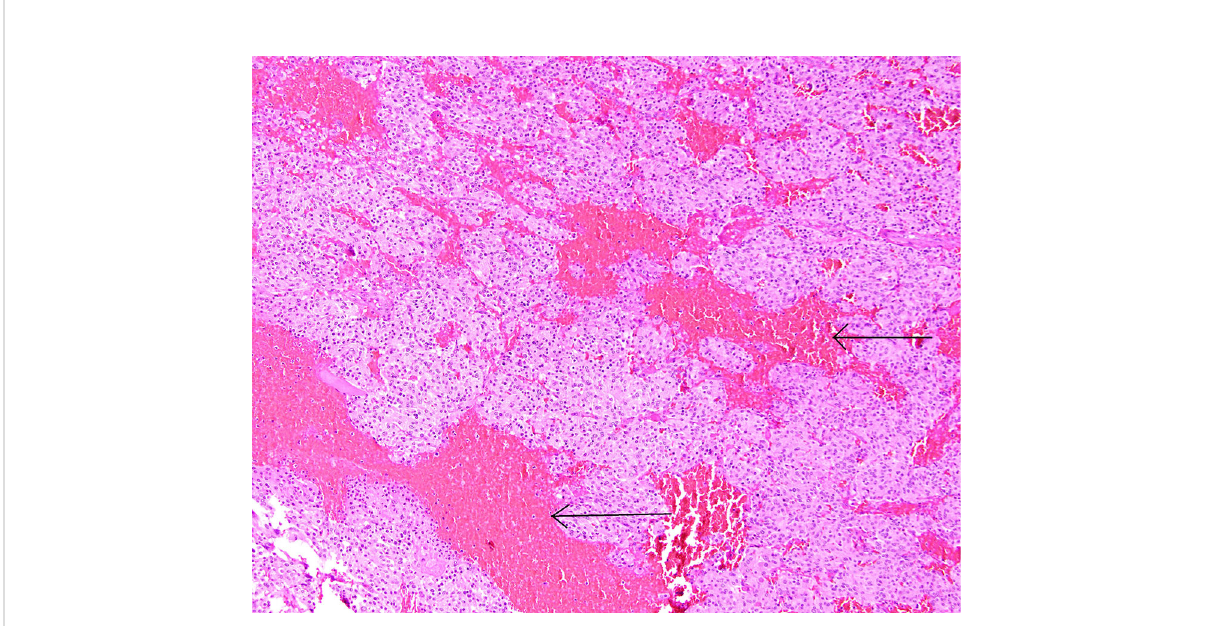
FIGURE 8 Patient number 2: central part of the pheochromocytoma with irregular, diffuse hemorrhages between tumour nests (thin